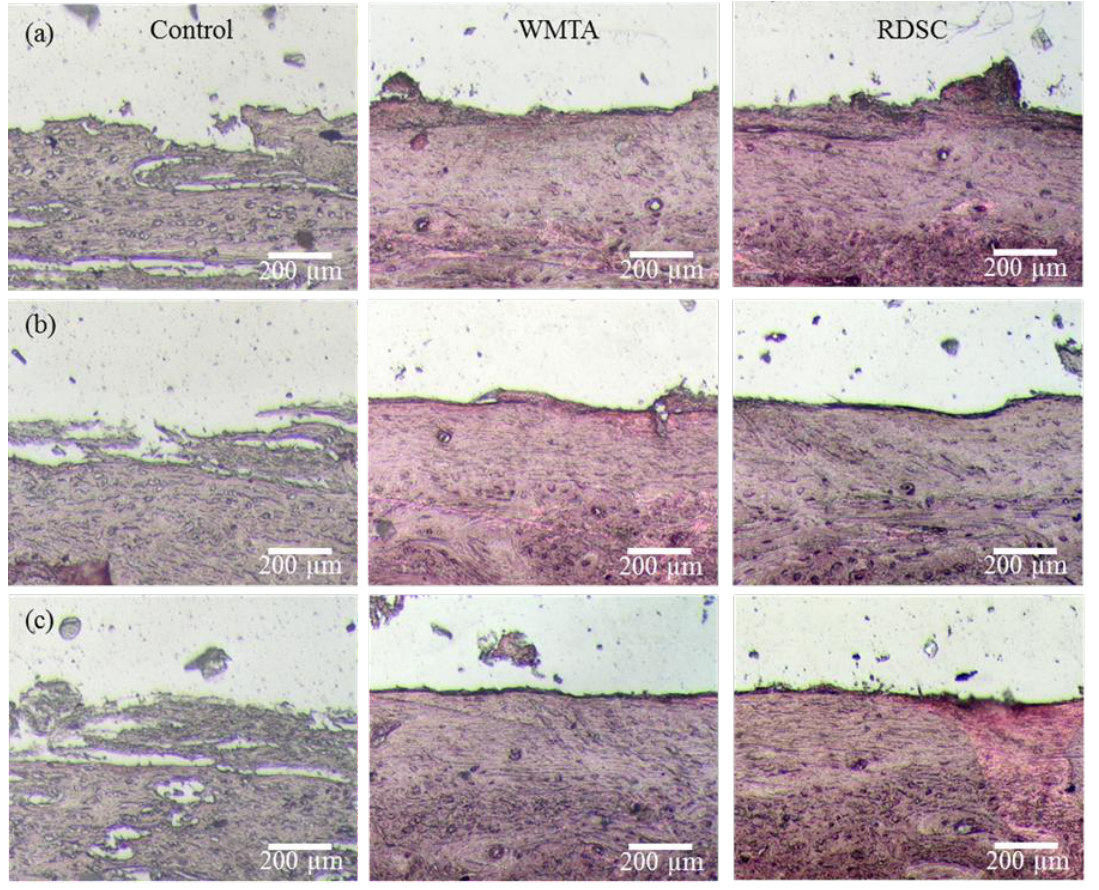
WMTA, and RDSC for different implantation time-points. ( a ) At 1-month the control was only lightly stained. WMTA and RDSC began to deposit mineral and the degree of bone apposition; ( b ) Mineral deposition in large areas was also confirmed at 3-month implantation; ( c ) Six months after implantation, osteoid formation was appreciated in the two cements at the defect edges. (Original magnification